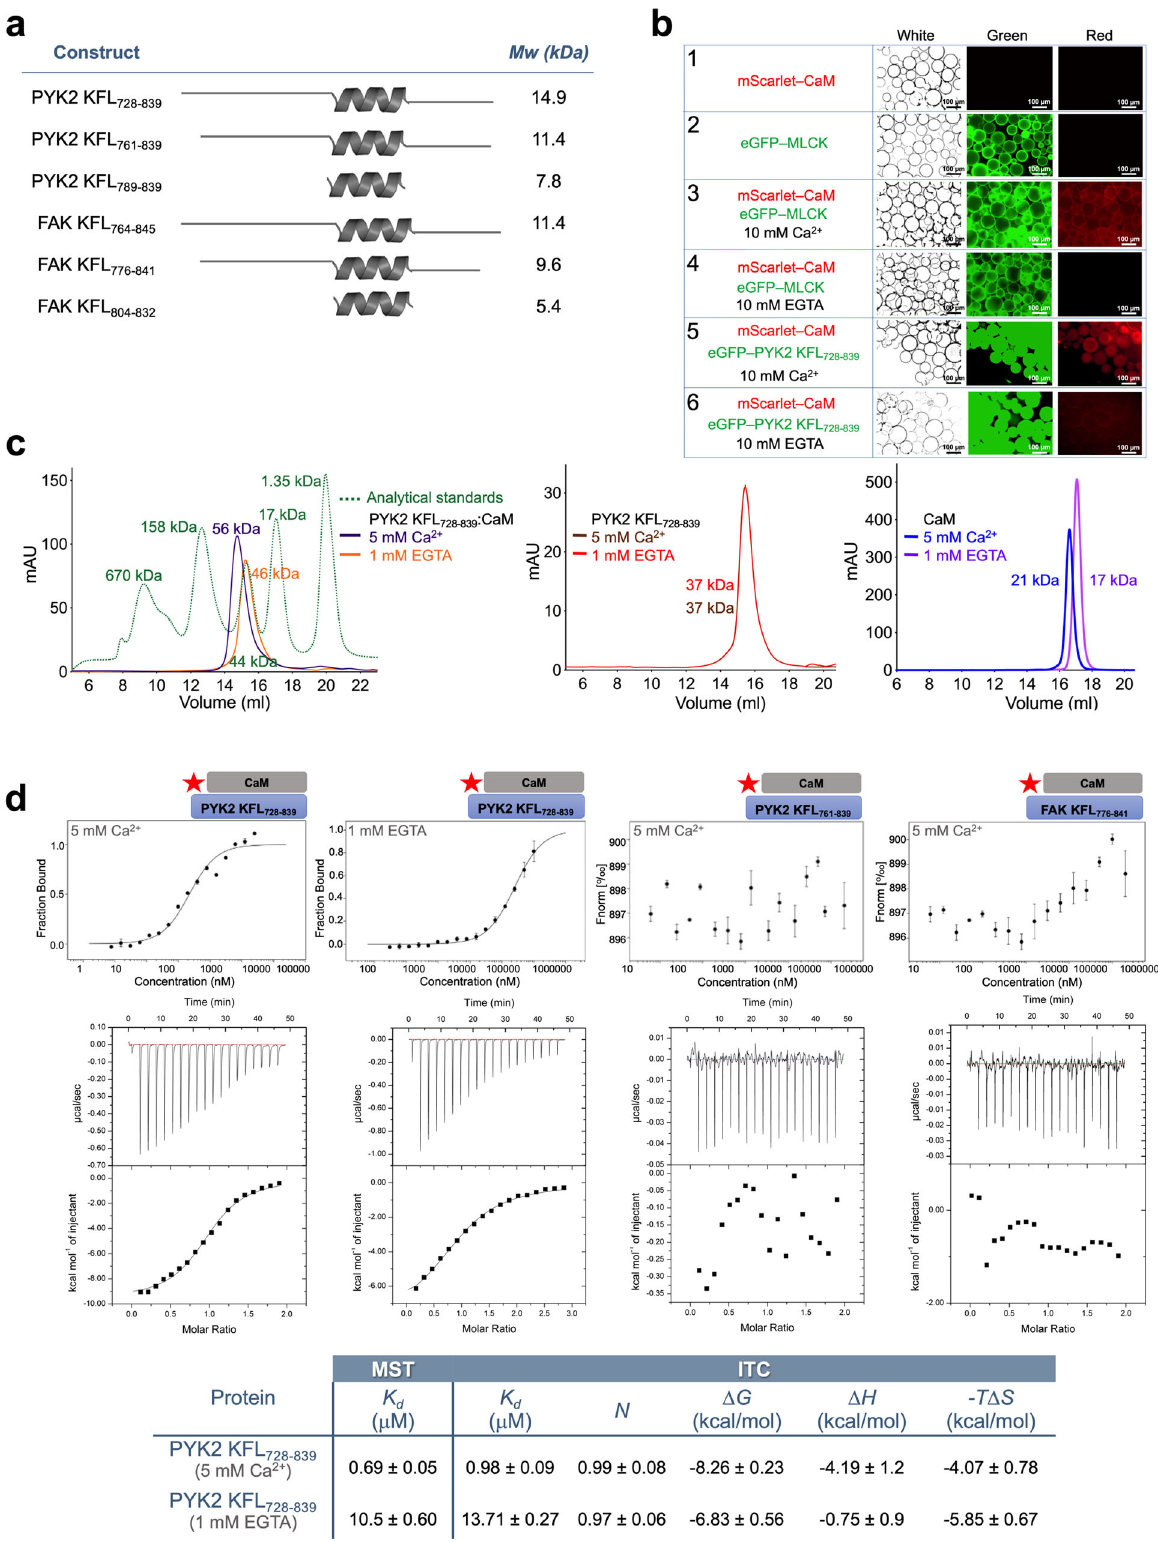
dicted bioinformatically (Supplementary Fig. 5a – e and Supple- mentary Table